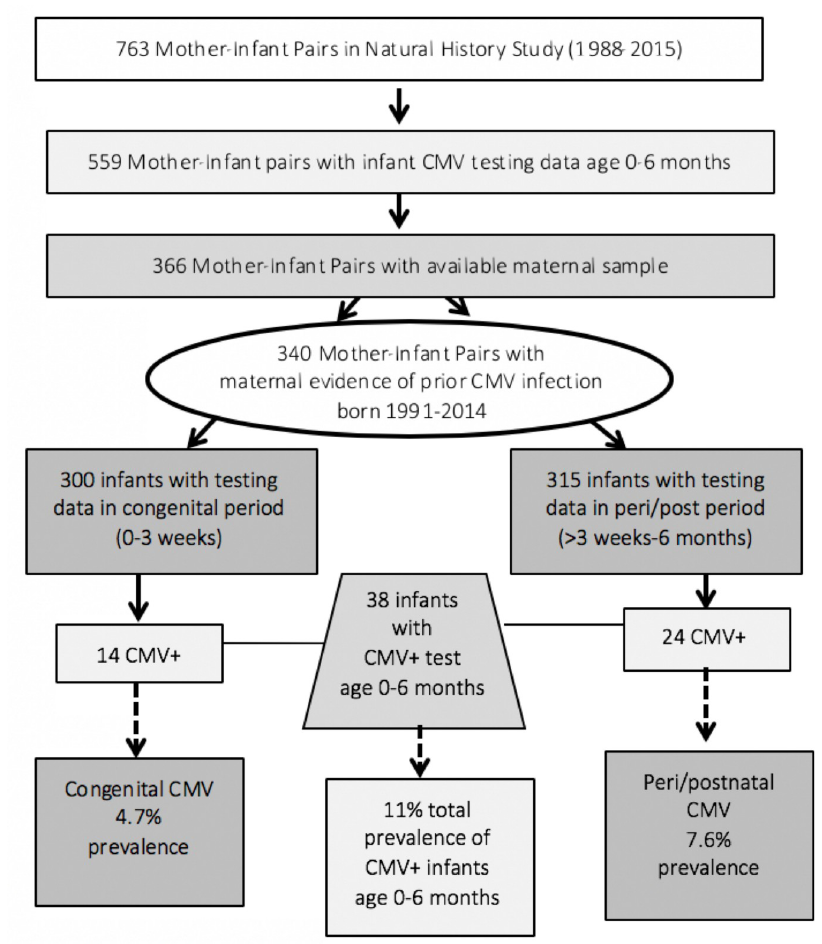
Fig 1. Study cohort based on infant CMV testing